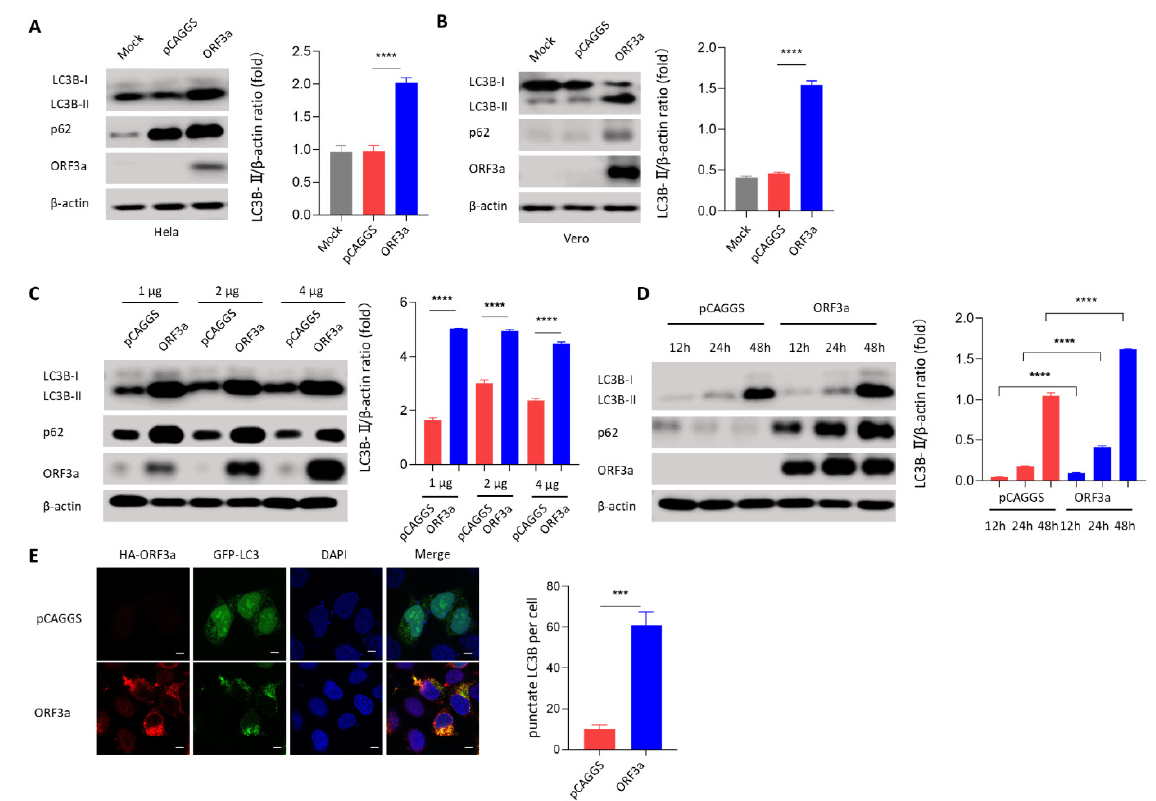
Figure 2. ORF3a could induce autophagy. ( A , B ) Hela and Vero cells (1–2 × 10 5 cells) were transfected with HA-Tag-ORF3a (2 µ g) or empty vector (2 µ g) for 24 h. Western blot was performed to detect LC3B and p62. ( C ) Hela cells (1–2 × 10 5 cells) were transfected with HA-Tag-ORF3a (1, 2, and 4 µ g) or empty vector (1, 2, and 4 µ g) for 24 h. Western blot was performed to detect LC3B and p62. ( D ) Hela cells (1–2 × 10 5 cells) were transfected with HA-Tag-ORF3a (2 μ g) or empty vector (2 μ g) for 12 h, 24 h, and 48 h. Western blot was performed to detect LC3B and p62. ( E ) Hela cells (1–2 × 10 4 cells) were co-transfected with GFP-LC3B (0.5 µ g) and HA-Tag-ORF3a (0.5 µ g) or empty vector (0.5 µ g) for 24 h. Immunofluorescence was performed to detect LC3B puncta. Scale bars: 4 μ m. Magnification: 630 x. One-way ANOVAs followed by Dunnett’s multiple comparisons test were used in comparing multiple groups. Student’s t-test was used to test statistical significance across two groups. Data were representative of 3 independent experiments. *** p ≤ 0.001, **** p ≤